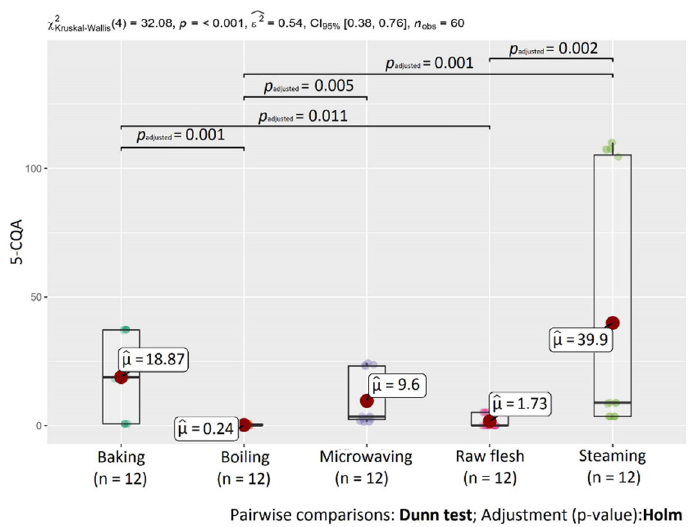
Figure 4. Statistical differences in chlorogenic acid contents between heat treatment methods.